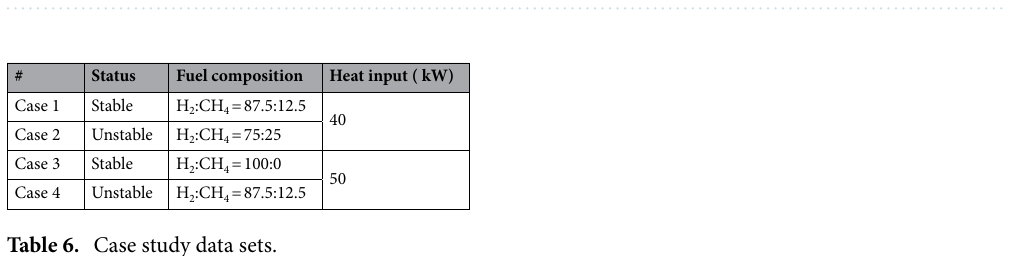
Table 5. Frequencies and corresponding amplitudes of combustion instability with respect to the H 2 :CH 4 ratio and heat input.